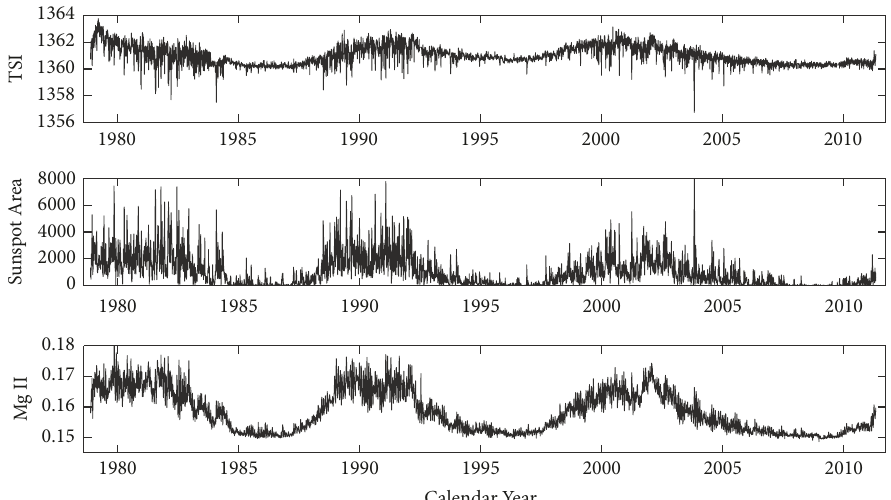
Figure 1: The three solar indices: daily ACRIM TSI (top panel), daily sunspot area (middle panel), and daily Mg II core-to-wingratio (bottom panel) from 1978 November 17 to 2011 April